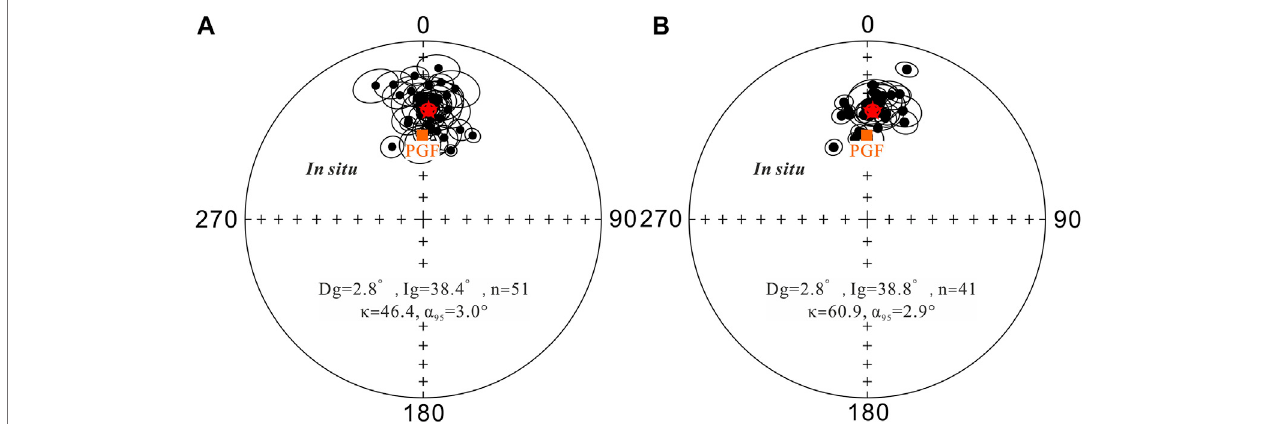
FIGURE 9 | Equal-area projections of the sample-mean directions of Type 1 (A) and Type 2 (B) granite based on principal component analysis (Kirschvink, 1980). The brown squares denote the direction of the present-day geomagnetic fi eld (PGF, D = 359.5 ° , I = 51.1 ° ) of the sampling location.